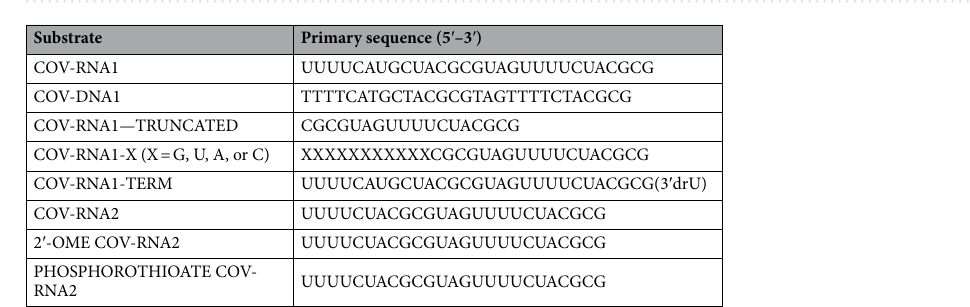
Figure 1. Nsp7,8,12 binds RNA substrates possessing a 5 ′ single-stranded overhang. ( a ) The secondary structure of a minimal RNA substrate recognized by the SARS-CoV-2 RdRp, coined CoV-RNA1. ( b ) Nsp7,8,12 binds the CoV-RNA1 substrate between 2.4 and 4.4 μM. ( c ) CoV-RNA1 binds nsp7,8,12 (2.4 µM) but not nsp12 alone (2.4 µM) or to the nsp7,8 protein–protein complex (2.4 µM). ( d ) The secondary struture of a trunctated CoV-RNA1 construct, lacking the 5 ′ single-stranded overhang. ( e ) Nsp7,8,12 does not bind the truncated CoV- RNA1 substrate. ( f ) Nsp12 forms contacts (i.e. H-bonds and electrostatic interactions) with RNA through the 2 ′ OH group of the ribose (PDB 7BV2 8 ). ( g ) The secondary structure of a DNA substrate, coined CoV-DNA1, is not recognized by nsp7,8,12 (2.4 µM). ( h ) The ribose modifications, 2 ′ -OMe or phosphorothioate, that are incoporated into the CoV-RNA2 substrate. ( i , j ) 2 ′ O-Me and phosphorothioate CoV-RNA2 substrates bind to nsp7,8,12 as low as 1.07 μM.